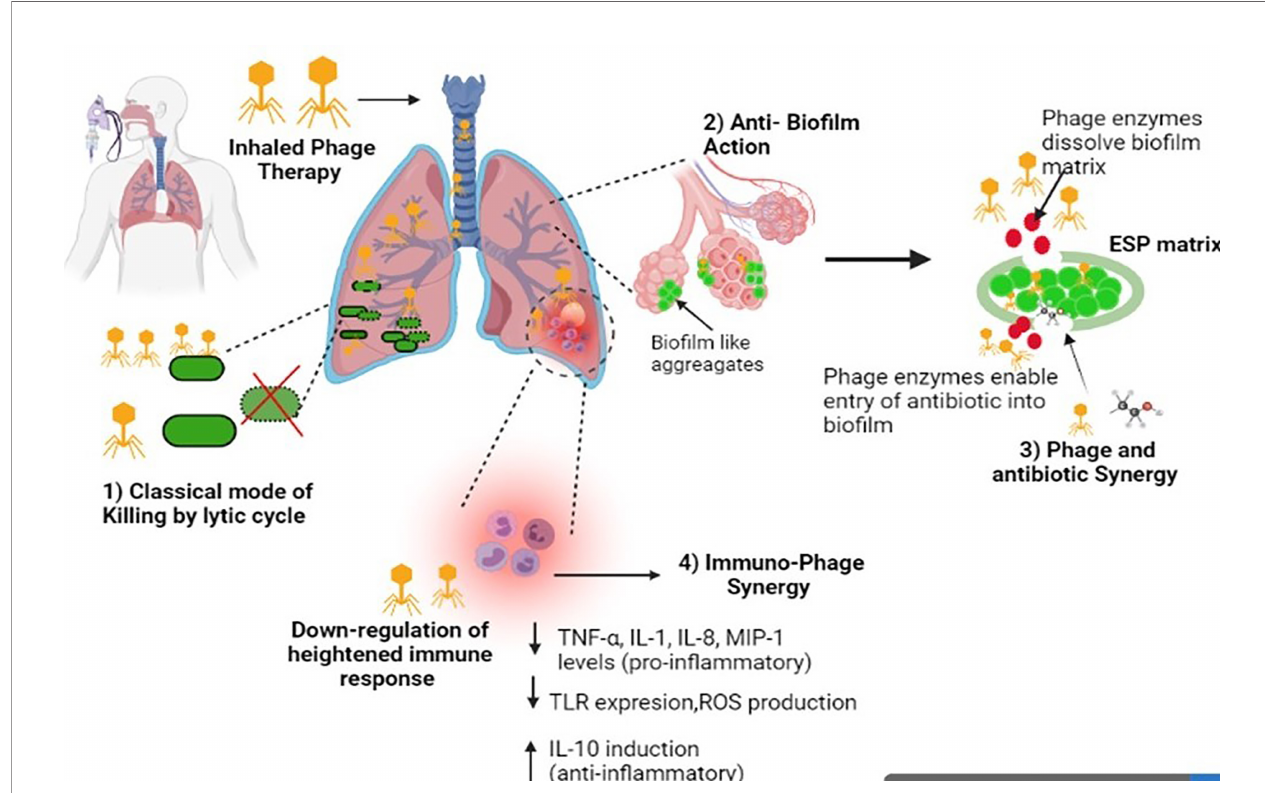
FIGURE 1 | Diagrammatic illustration of the multiple mechanisms of phages against respiratory infections. Image created in